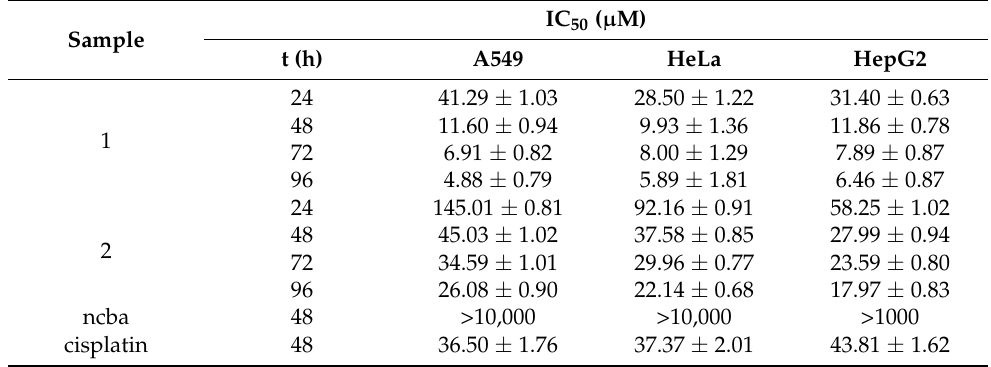
Table 2. IC 50 of complex 1 and complex 2 against A549, HeLa, and HepG2 at various time points.